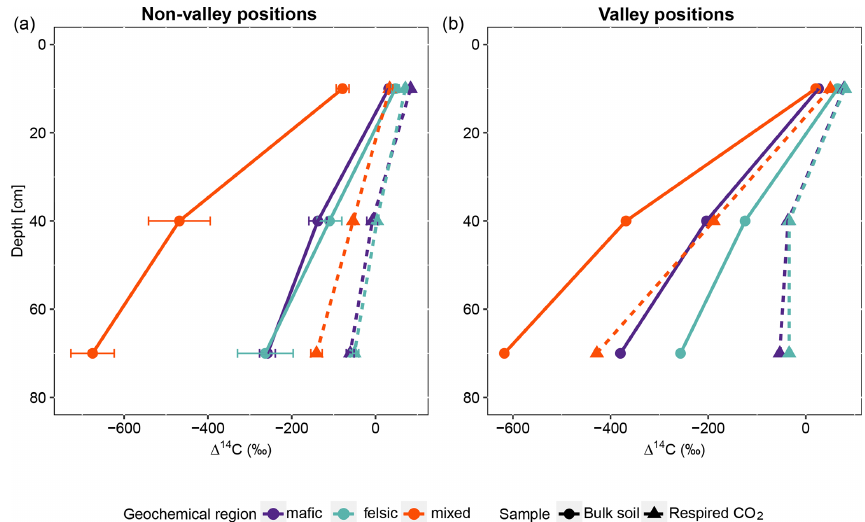
Figure 2. Average and standard errors based on all composite samples for non-valley positions only. (a) Radiocarbon content ( (cid:49) 14 C) of the bulk soil and respired CO 2 for non-valley positions. (b) (cid:49) 14 C of the bulk soil and respired CO 2 for valley positions ( n = 27 for non-valleys and n = 9 valleys for each depth interval). Note that at non-valley positions, each point in panel (a) represents three observations from composite samples. At valley positions, each point in panel (b) represents one observation from composite samples. Table 2. Biogenic and fossil organic carbon contribution in the mixed sediment region to SOC and respired CO 2 as a percent of total C and ratio bulk soil/respired C for both parameters. Values are displayed separately for non-valley and valley positions per soil depth ( n = 1 per soil depth and position due to merging of replicates into composites prior to analysis). We note that these values are an upper bound on the contribution of fossil organic C, as these estimates may be affected by variable rates of biogenic C cycling. Position Depth (cm) Biogenic (%) Fossil